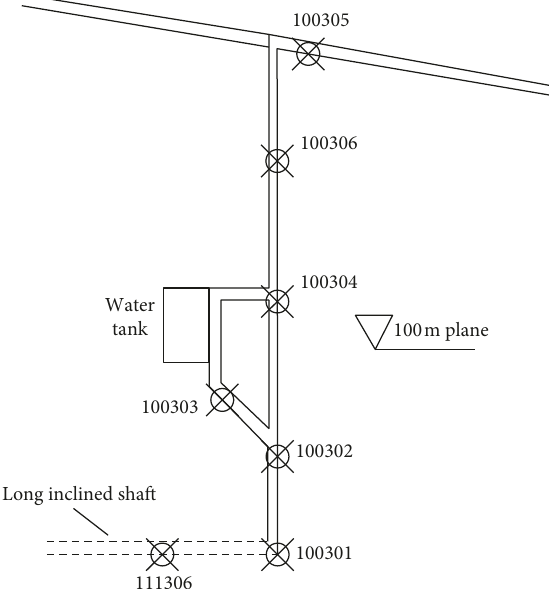
Figure 4: 100m plane sensor layout.